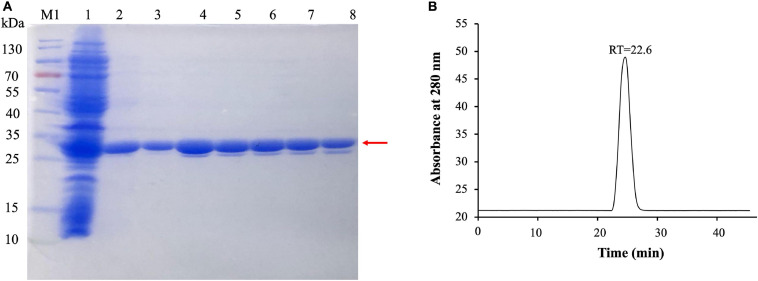
(A) SDS-PAGE of the expression and purification of (VIBVN)NAT in E. coli BL21(DE3) cells. Detailed legend: Lane M1: Protein marker. Lane 1: Supernatant after cell lysate centrifugation (loading). Lane 2: Flowthrough with 50 mM Tris–HCl, 150 mM NaCl, and 20 mM imidazole (pH 8.0). Lanes 3–5: Elution with 50 mM Tris–HCl, 150 mM NaCl, and 40 mM imidazole (pH 8.0). Lane 6–8: Elution with 50 mM Tris–HCl, 150 mM NaCl, and 200 mM imidazole (pH 8.0). Molecular weight determination by using SDS-PAGE. (B) Gel filtration chromatography analysis of (VIBVN)NAT. The enzyme was prepared at a concentration of 5 mg/mL in PBS buffer. Approximately 100 μl of the sample was injected onto the column. The relative amount of the main form of the enzyme (retention time (RT) = 22.6 min) was present in the sample.